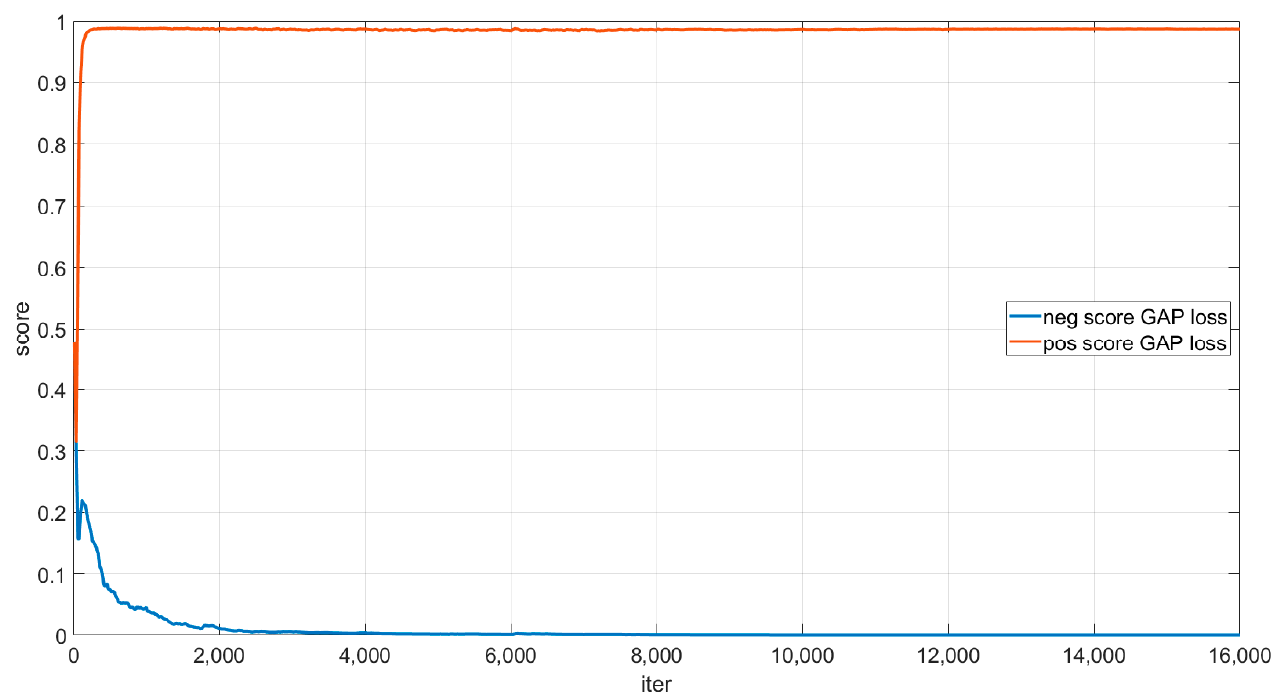
Figure 6. Curves of the average classification scores of positive and negative samples output from the network trained by GAP loss during the training phase.